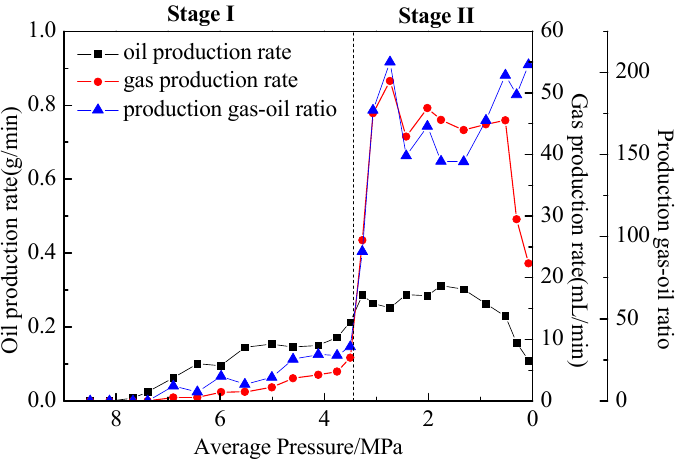
Figure 6. Characteristics for conventional solution gas drive (taking test 8 as an example).